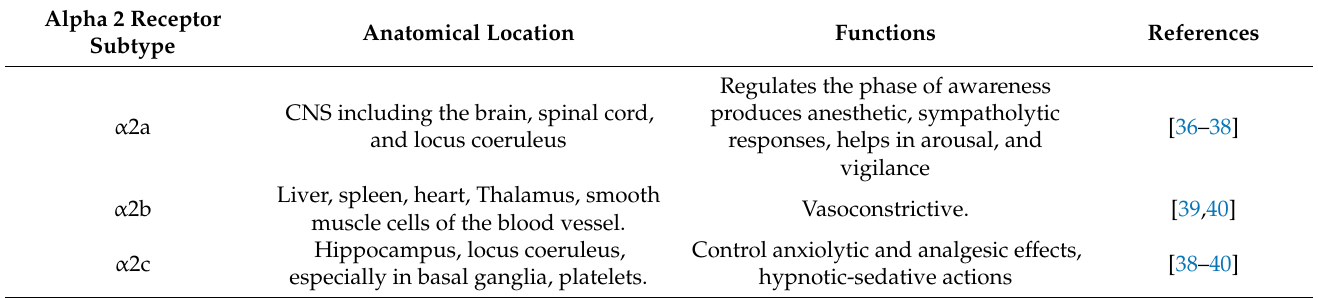
Table 1. Alpha 2 receptor subtypes, anatomical location, and